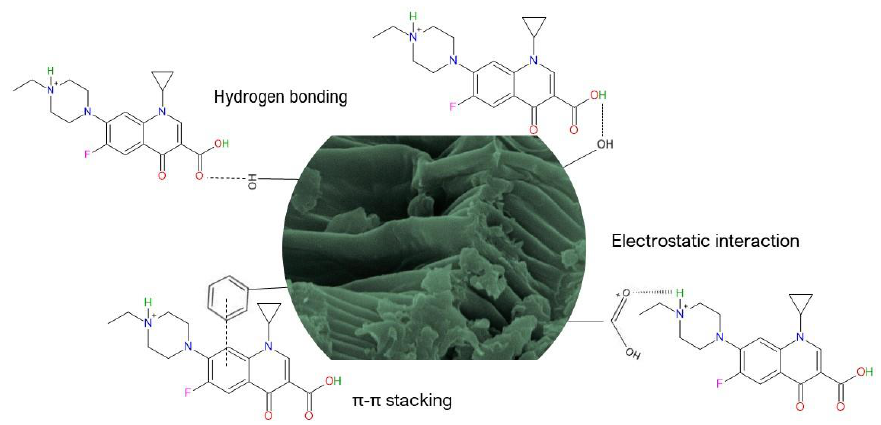
Figure 10. Mechanisms proposed for the adsorption of enrofloxacin onto P. koidzumii sorbent.